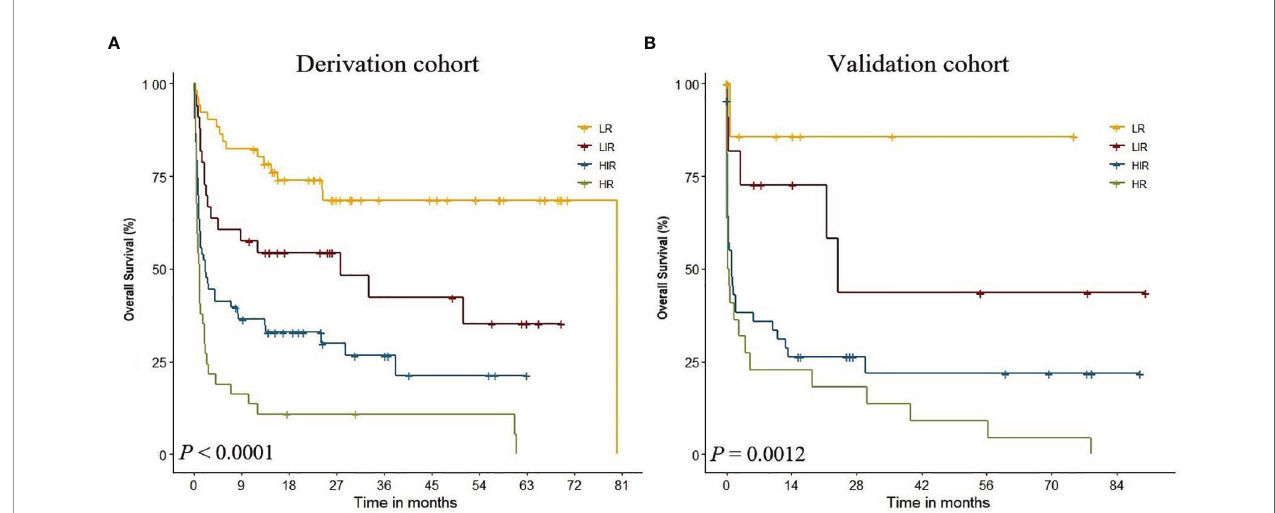
FIGURE 6 | KM analysis of four risk groups in derivation (A) and validation (B) cohort by HHLWG-HPI.